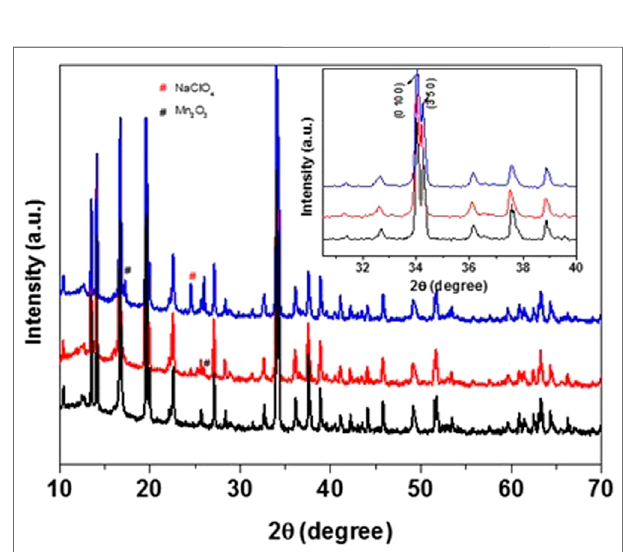
FIGURE 6 | Powder XRD patterns of NMO samples: untreated (black) and heat-treated (60 ° C for one week) in 8 m (red) and saturated (blue) NaClO 4 electrolyte